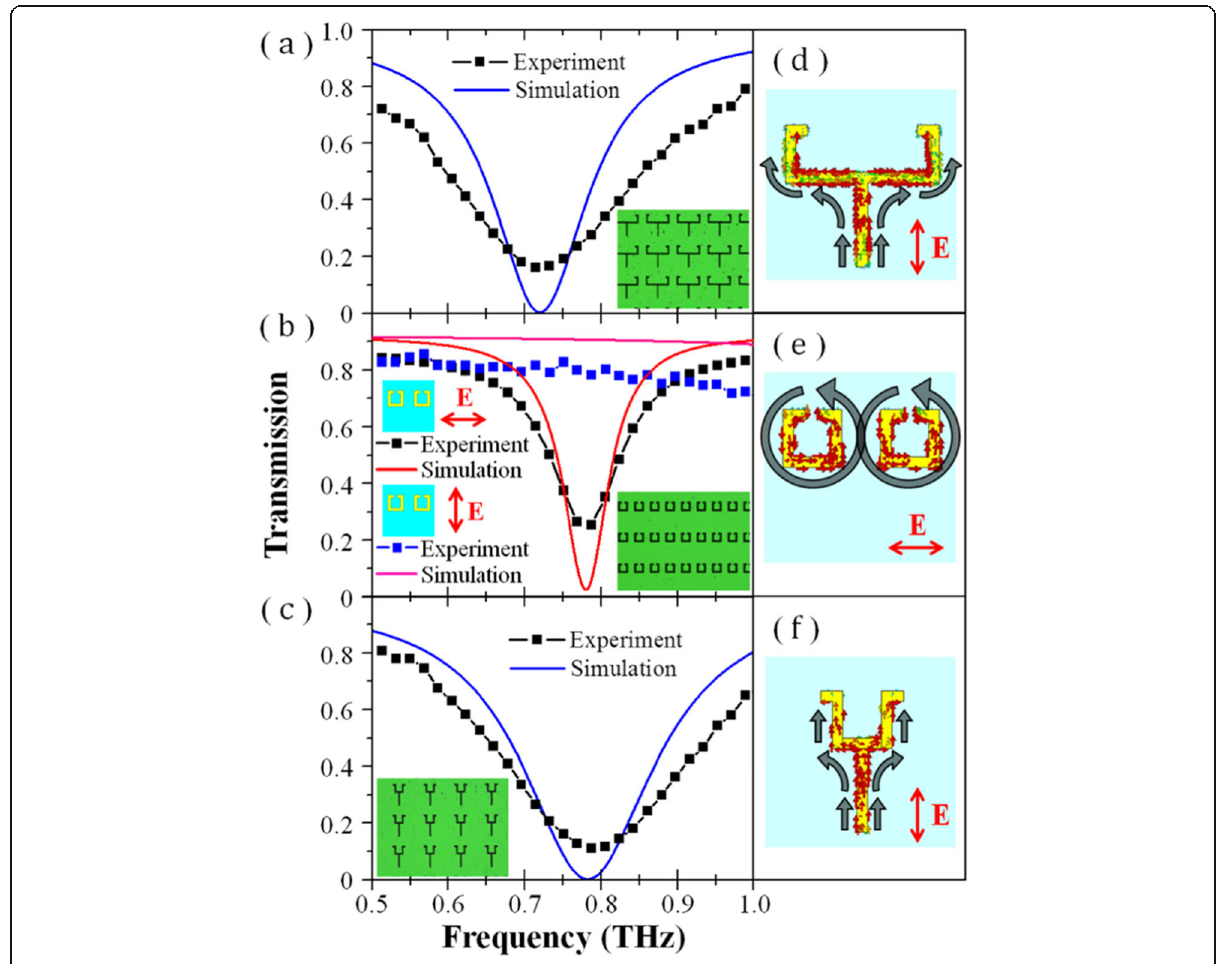
Fig. 9 Simulated and measured spectra of different components of the conductively coupled terahertz EIT metamaterial: a the combined structure of the metal bar and the outer part of the SRRs, b SRR combination, c the combined structure of the metal bar and the inner part of the SRRs; The microscopic images of the fabricated components are also inserted in the corresponding spectra; d-f Surface currents of the corresponding resonances in